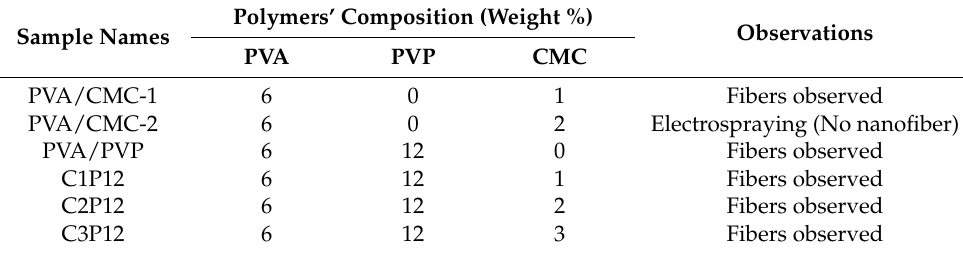
Table 1. Polymer composition in tri-component composite